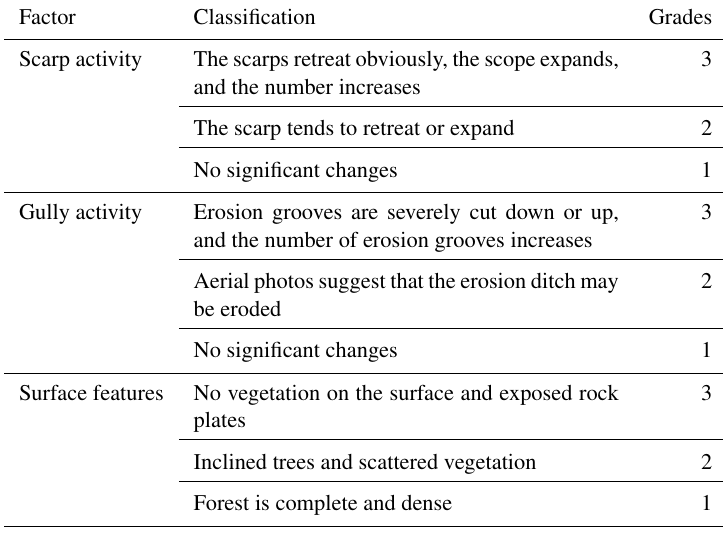
Table 4. Activity grades including colluvium features (referred to as Activity 2) (modified from Lin, 2017).